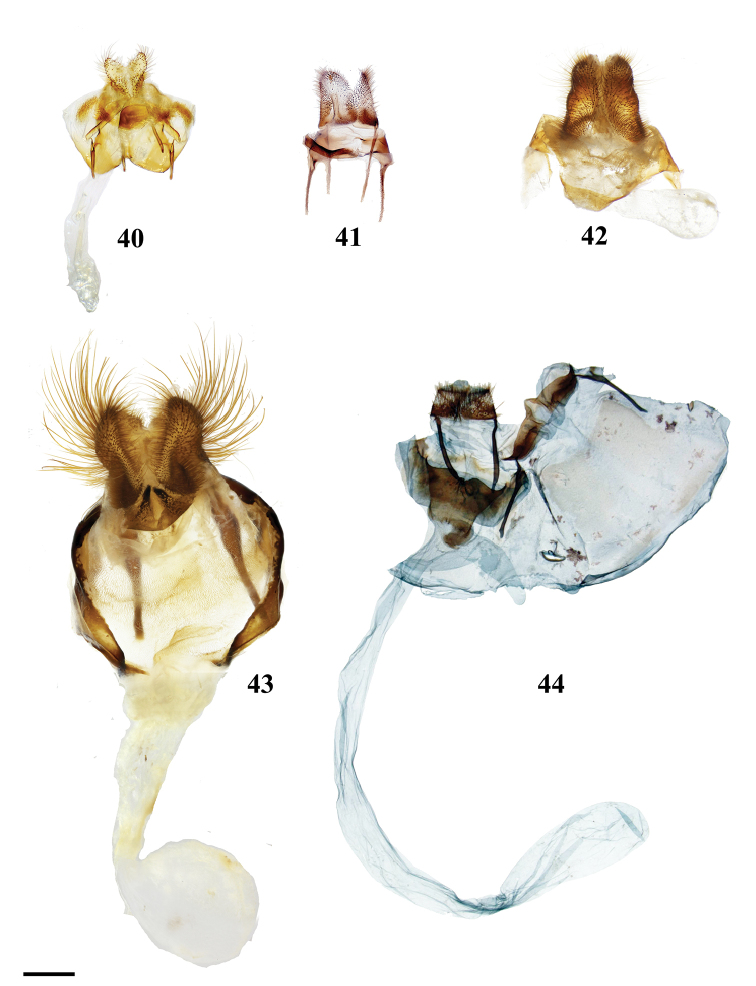
Ventral view of female genitalia of type species (except where noted) of genera belonging to Zaphantinae, incertae sedis, and Aurorianinae. 40Zaphantainfantilis, genitalia vial NHMUK 010402342 41Menevialantona, St Laurent diss.: 7-8-15:1, ductus and corpus bursae missing [adapted and modified from St Laurent and Dombroskie (2016)] (USNM) 42Tolypidaamaryllis, St Laurent diss.: 3-31-18:1 (CRAS) 43Roelofaolivia, genitalia vial NHMUK 010402328 (NHMUK) 44Aurorianaflorianensis, C. Gibeaux diss. prep: 7759, not the type species of Auroriana, [reused with permission from St Laurent and Mielke (2016), ZooKeys] (MNHN). Scale bar: 1 mm.